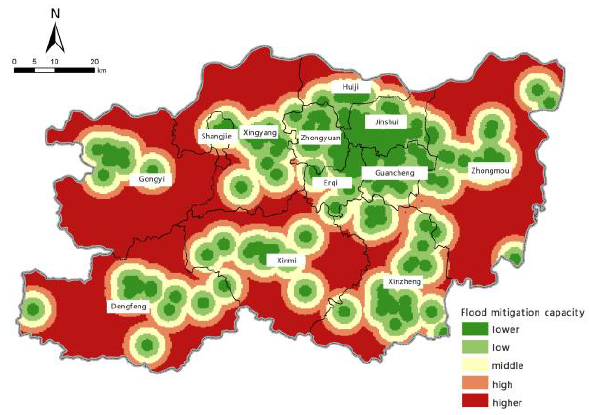
Figure 9. Zoning map of flood-mitigation capacity.